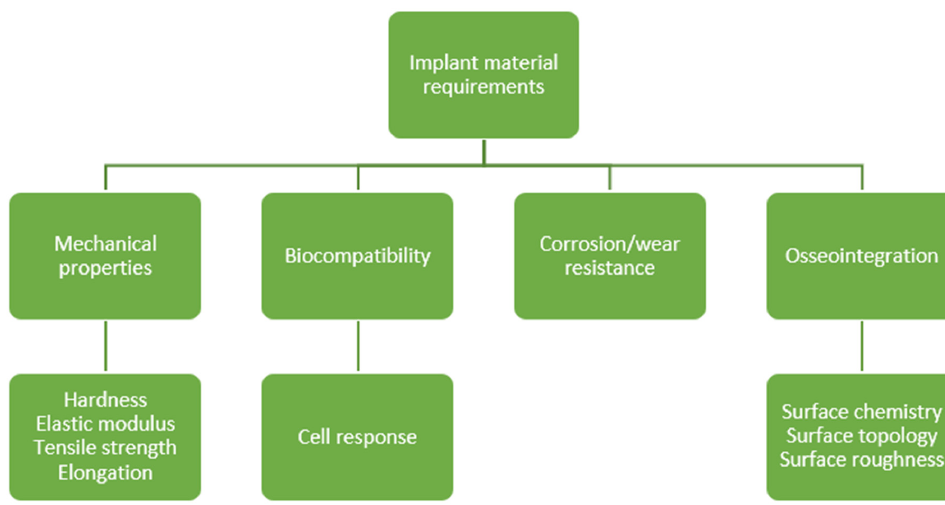
Figure 4. Important parameters of implants [60].